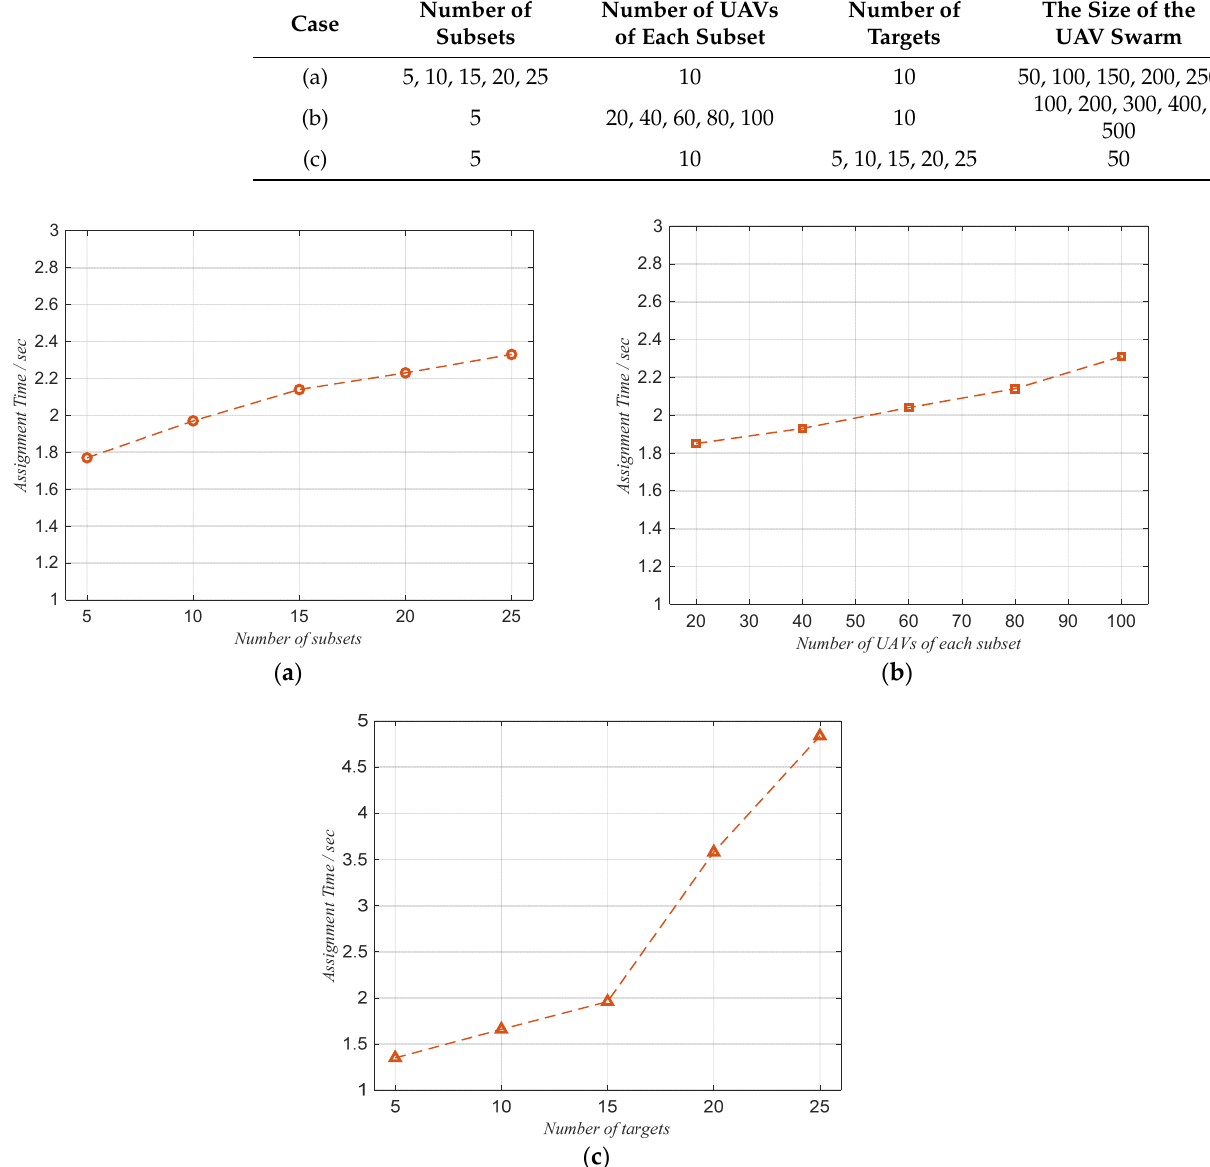
Figure 15. Assignment time varies with ( a ) the number of subsets, ( b ) the number of UAVs of each subset, and ( c ) the number of targets.